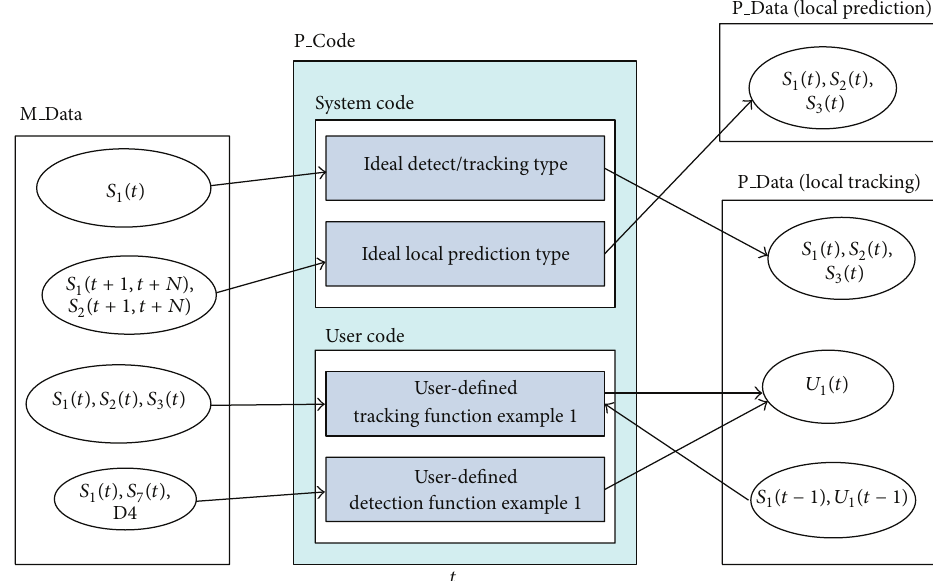
Figure 9: Perceiver code